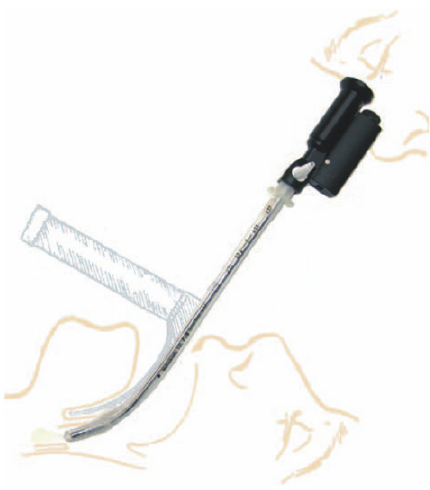
Figure 2: Levitan FPS optical stylet (source: manufacturer market- ing materials).